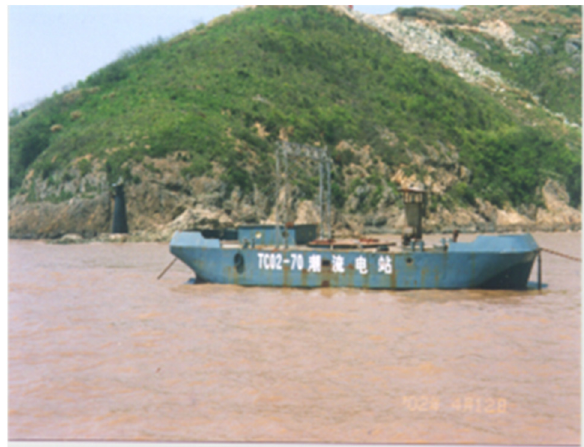
Figure 3. “Wanxiang I”—experimental floating TCPGS. Reproduced from [21], Elsevier.